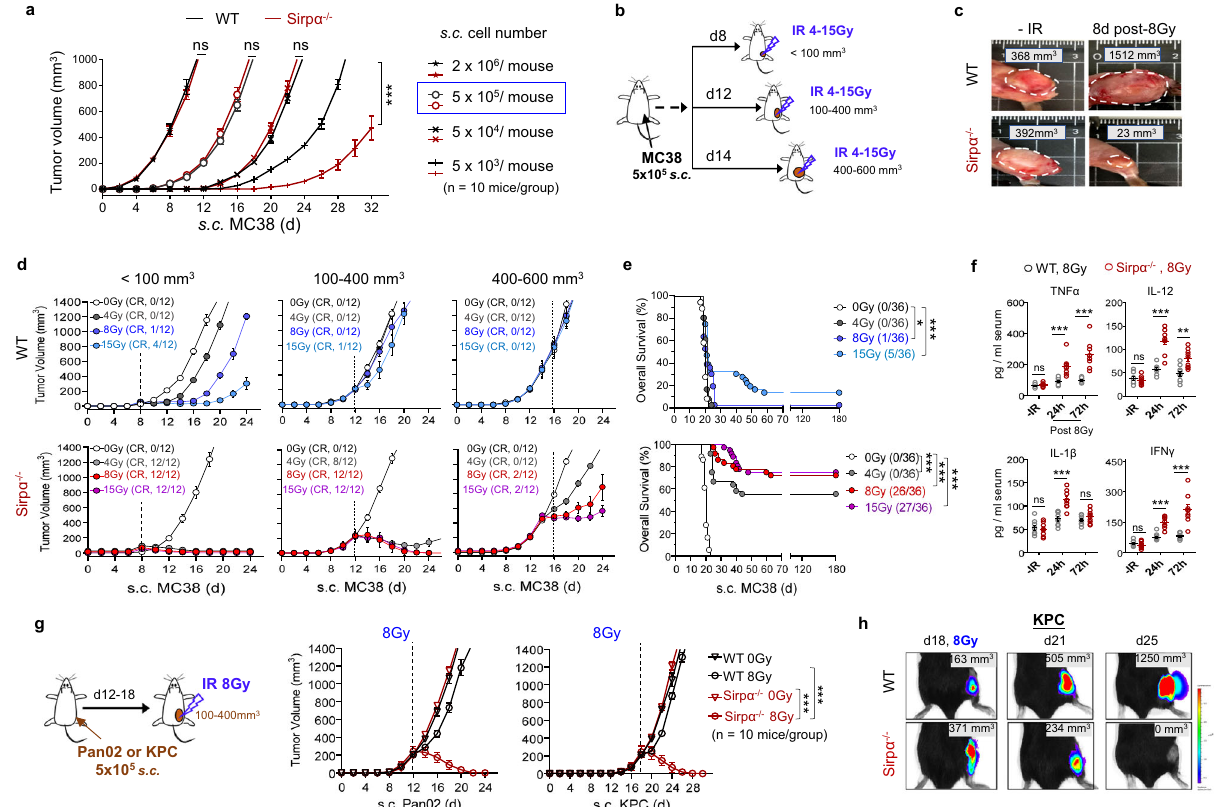
Fig. 1 Local RT eliminates late-stage MC38 tumors in Sirp α − / − mice but not WT mice. a Growth of MC38 tumor in WT and Sirp α − / − mice. Various numbers of MC38 cells were engrafted into WT and Sirp α − / − mice via s.c . injection. Data from three independent experiments (3 – 4 mice/group in each experiment) are presented as mean ± SEM. n = 10 mice in each group. *** P < 0.001. b RT scheme. MC38 cells (5 × 10 5 ) were subcutaneously ( s.c